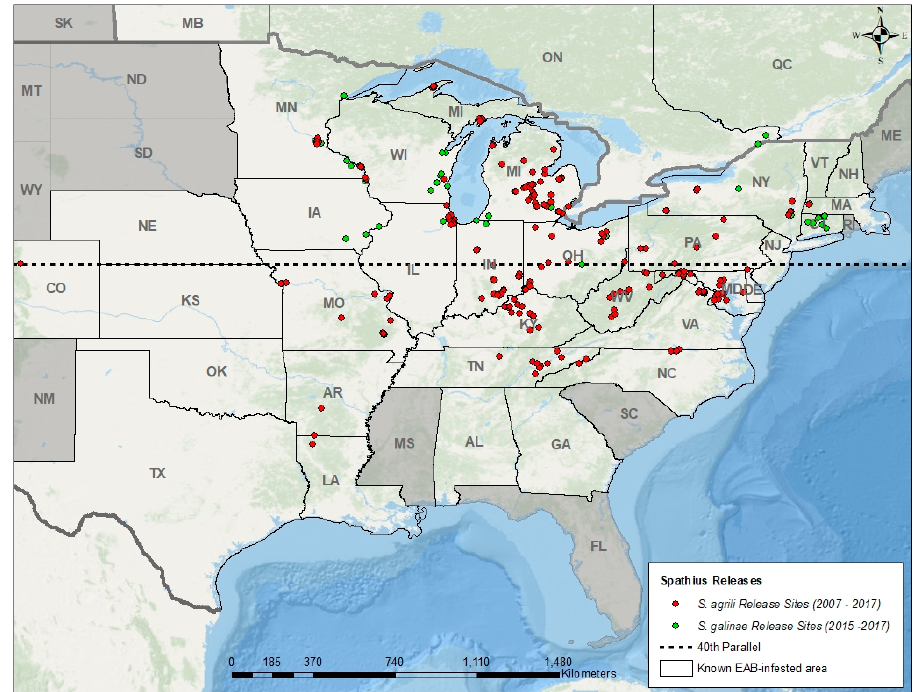
Figure 1. Map showing known regions of North America invaded by EAB, and locations where Spathius agrili and S. galinae were released by fall 2017 [84]. In the United States, releases of S. agrili and S. galinae began in 2007 and 2015, respectively. In Canada, release of S. galinae began in 2017. In 2013, release of S. agrili was limited to EAB infestations south of the 40th parallel due to lack of establishment further north. No recovery sites for Spathius are shown because establishment of S. agrili was found at only one release site, and it is too soon to confirm establishment of S. galinae .